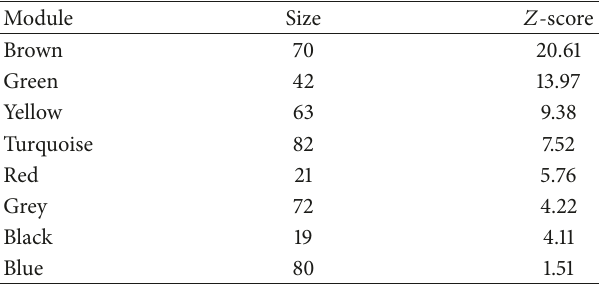
Table 3: Metabolite module preservation and ability to distinguish between small dogs and dogs of larger body size.